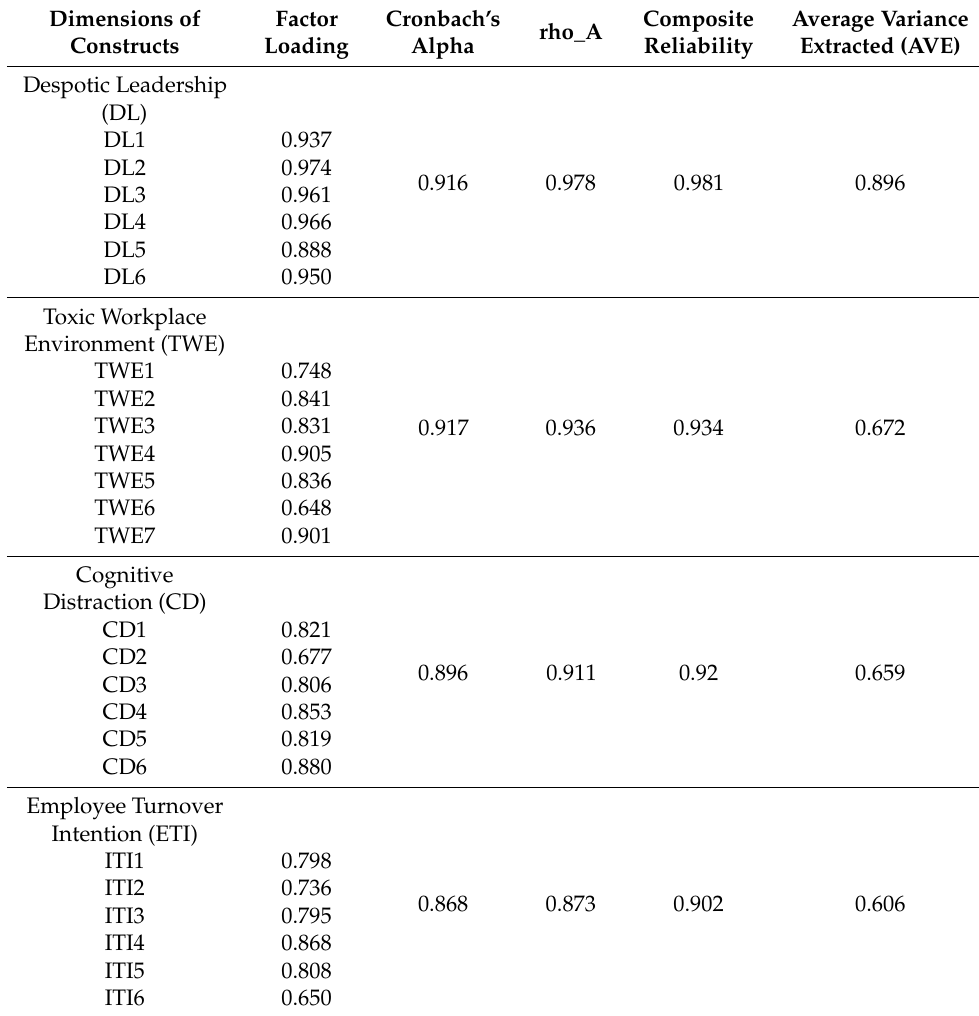
Table 2. Reliability and convergent